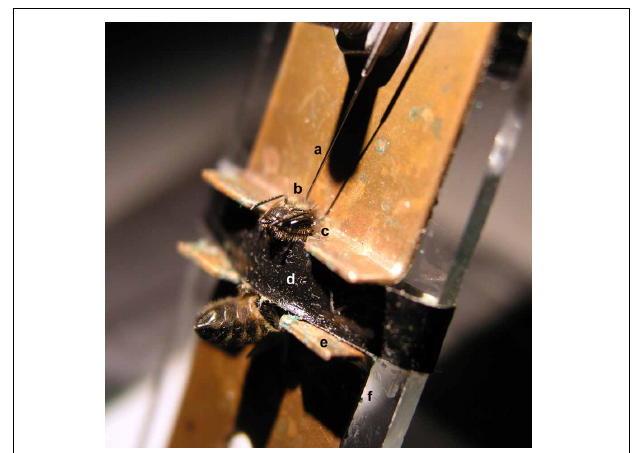
FIGURE 1 | Brain injection via the ocellar tract in a honey bee harnessed on a shock delivery setup. A tiny hole was pricked into the cornea of the median ocellus to allow the insertion of a Hamilton syringe (a) located above the bee. The syringe allows delivery of the drug to be tested in the median ocellar tract (b) , which runs medially and caudally from the dorsal margin of the head capsule into the protocerebrum. The head of the bee is fixed to the metallic plate by means of a low-temperature melting wax (c) to reduce movements during injection. A girdle (d) is used to clamp the thorax to restrain mobility during the experiment. The bee acts as a bridge between the two metallic plates (e) fixed on a Plexiglas plate (f) . EEG cream was smeared on the two notches of the metallic plates to ensure good contact between the plates and the bee. The bee closes a circuit and receives a 2-s mild electric shock which induces the sting extension reflex